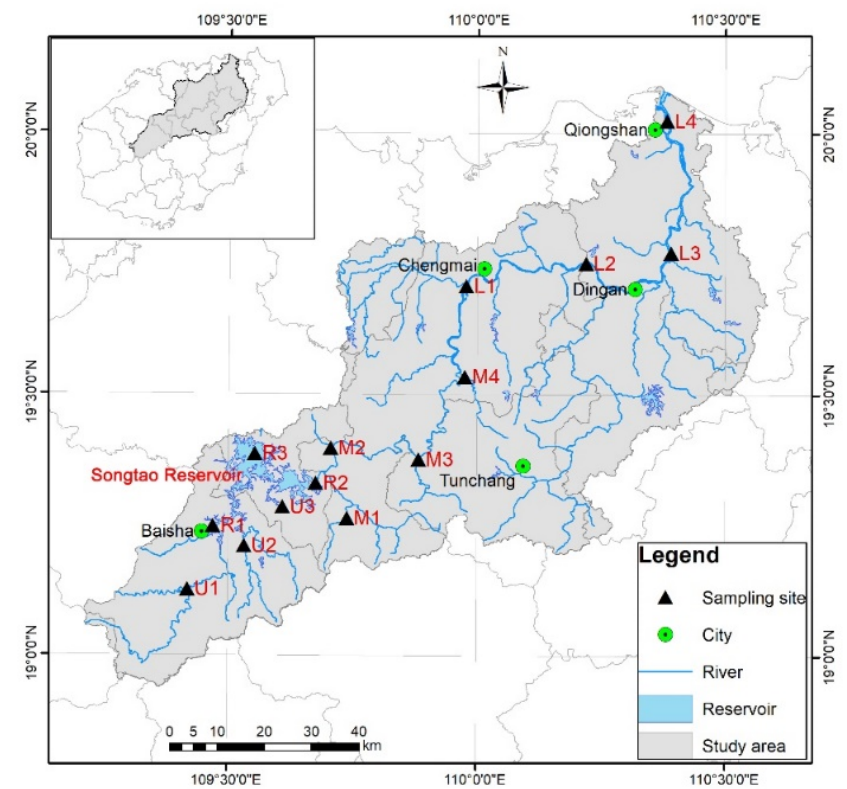
Figure 1. Sampling sites in the Nandu River.